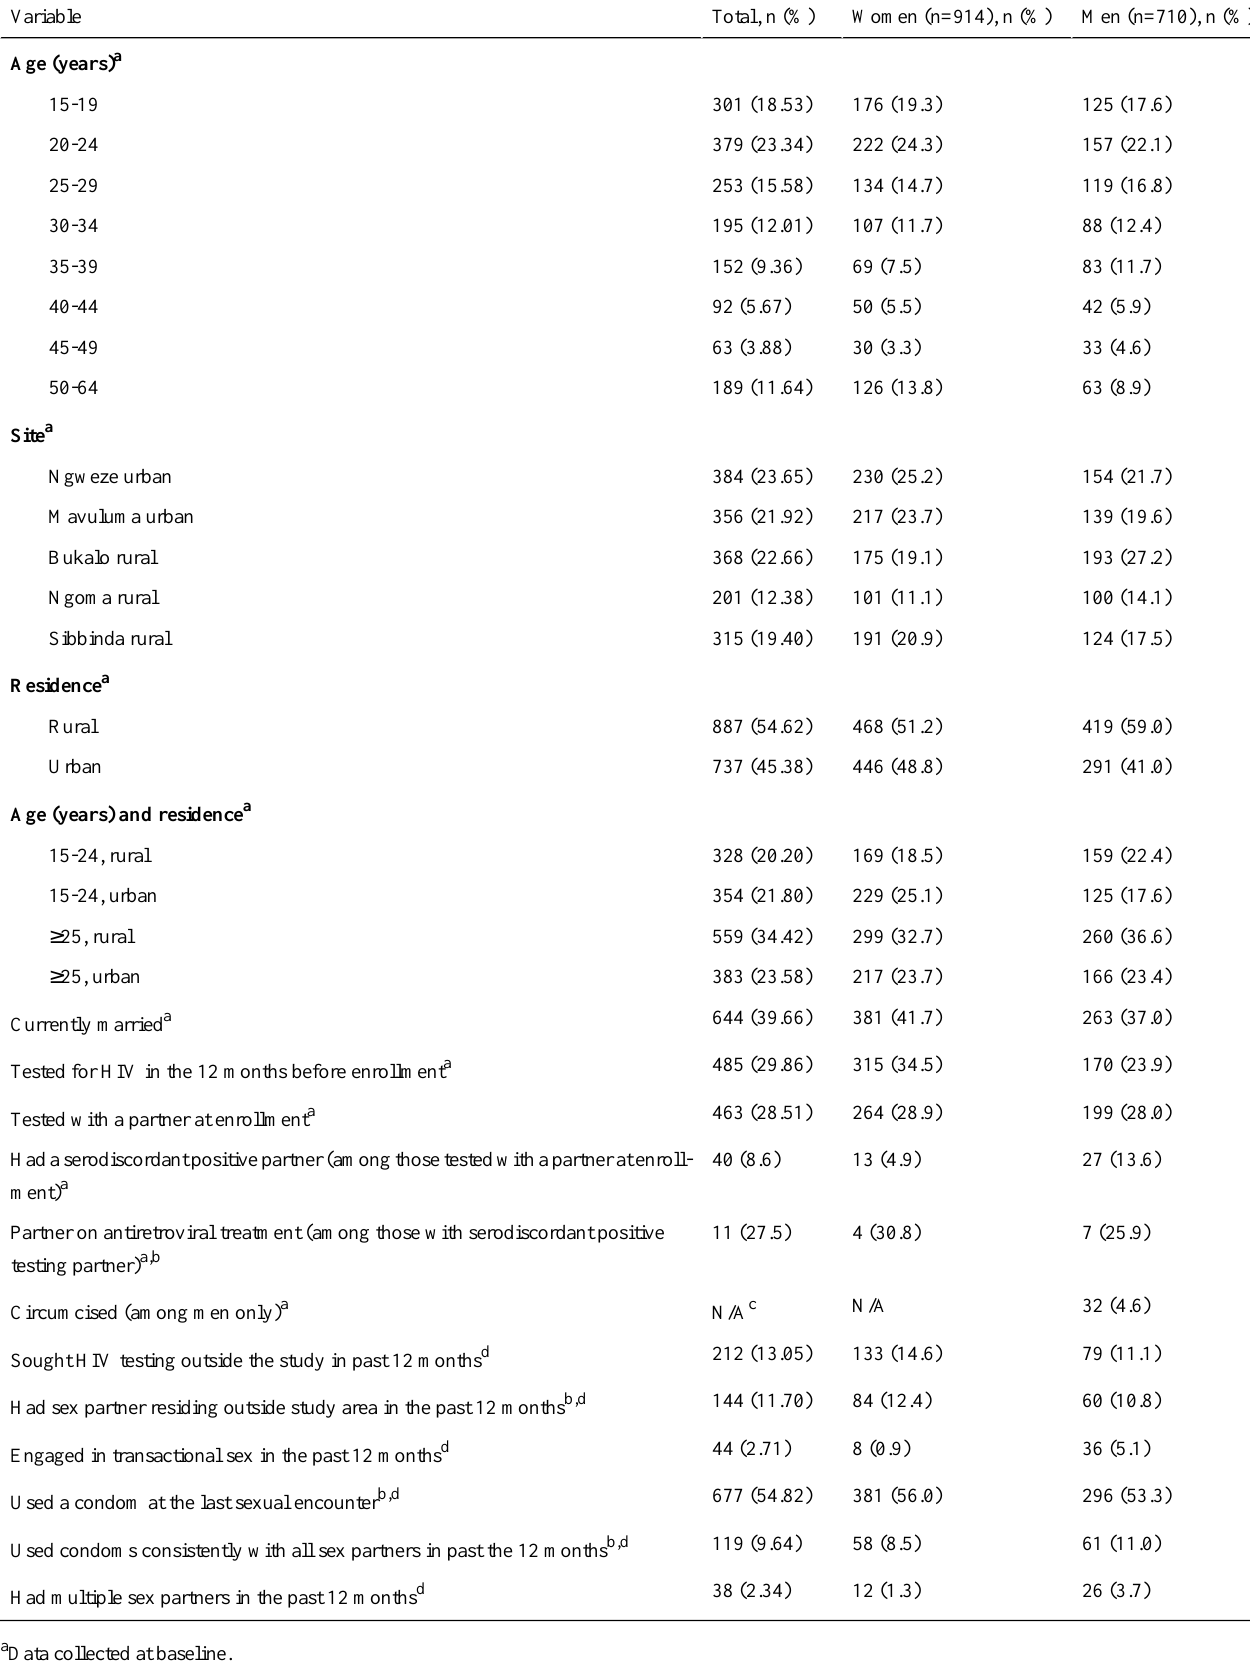
Table 1. Demographic and behavioral characteristics of HIV-negative participants who completed baseline and follow-up measurements—household cohort study of adults aged ≥ 15 years in the Zambezi region of Namibia, 2014 to 2016